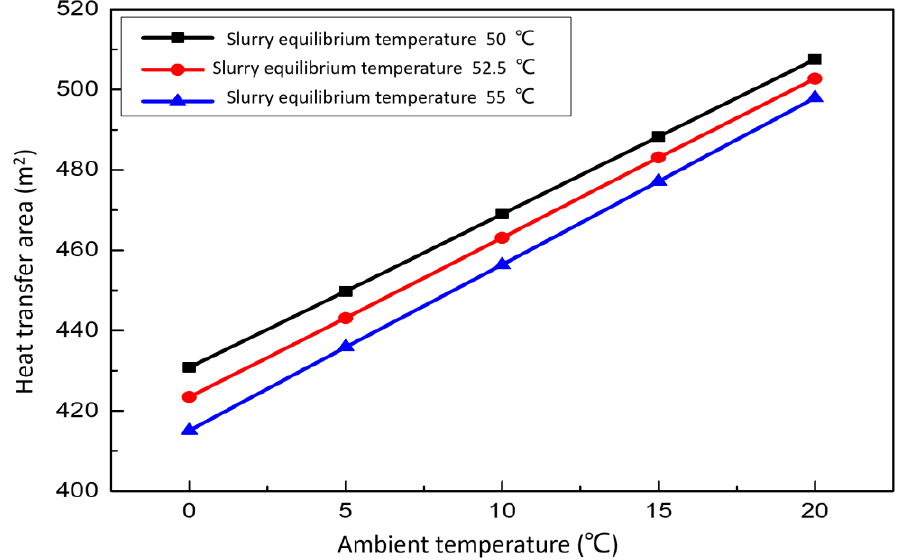
Figure 13. Effect of ambient temperature on the heat transfer area.